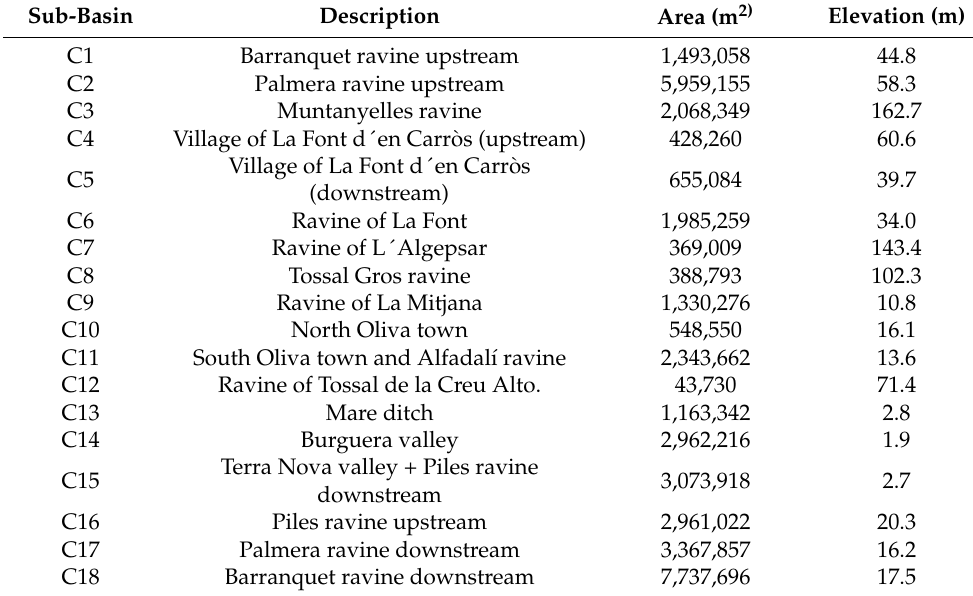
Table 1. Sub-basin areas and their centroid elevation. Description gives the local name of the riverbed; note that the same riverbed is sometimes named with different local names through its run (e.g., C3, C6, C9, and C14 correspond to the same